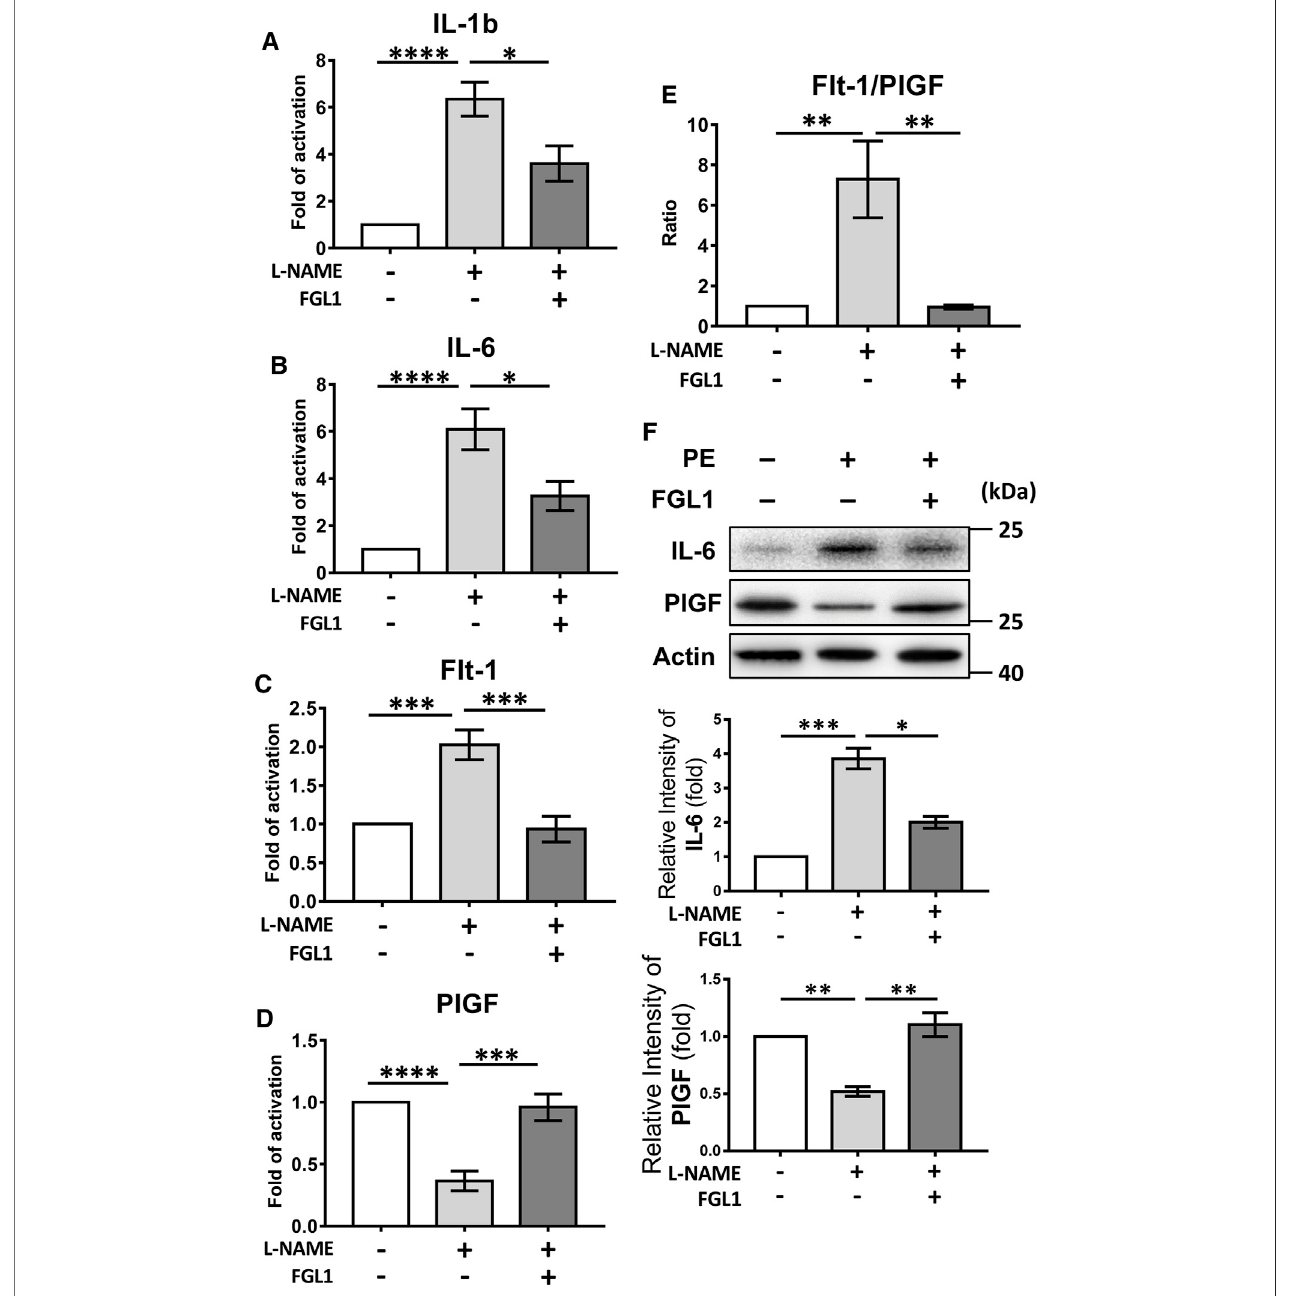
FIGURE 4 | Effects of FGL1 treatment on proin fl ammatory cytokines and angiogenic markers in placentas from mouse with PE. After injection of L-NAME with or without FGL1, the placenta on the 18th day of pregnancy was subjected to quantitative real-time RT-PCR (qPCR) to evaluate the mRNA expression of proin fl ammatory cytokines and angiogenic markers. (A) Interleukin (IL)-1b. (B) IL-6. (C) FMS-like tyrosine kinase 1 (Flt-1). (D) Placental growth factor (PlGF). (E) Flt-1/PlGF ratio of mRNA level, n (cid:1) 6/group. (F) ProteinlevelsofIL-6andPlGF.Theexperimentswererepeatedatleastthreetimes.* p < 0.05;** p < 0.01;*** p < 0.001;**** p < 0.0001(Tukey ’ s